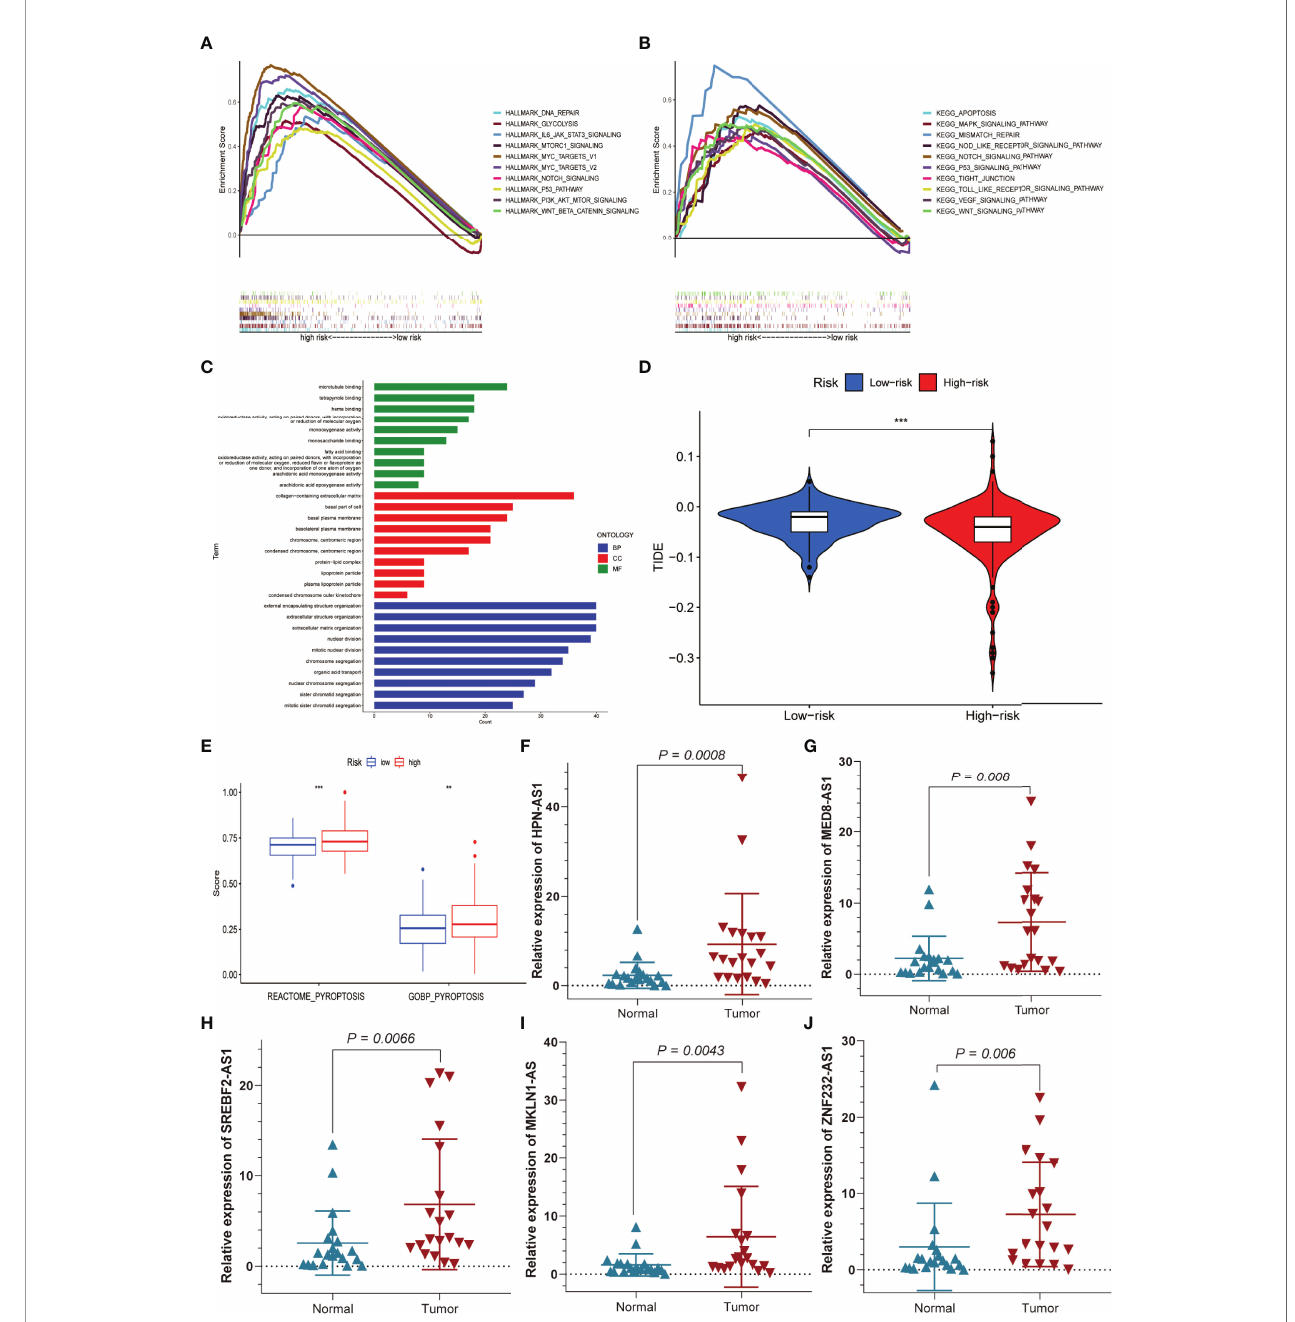
FIGURE 10 | Functional enrichment analysis, sensitivity to immunotherapy, and pyroptosis scores for the high- and low-risk groups, and external experimental validation of fi ve PR-lncRNAs. (A) Hallmark gene set. (B) KEGG, Kyoto Encyclopedia of Genes and Genomes. (C) GO analysis. (D) TIDE score for the high- and low- risk groups. (E) Differences in pyroptosis scores between the low and high-risk groups. (F – J) The experiment con fi rmed the difference in the prognostic lncRNA expression between HCC and adjacent non-tumour tissues. **P < 0.01; ***P <